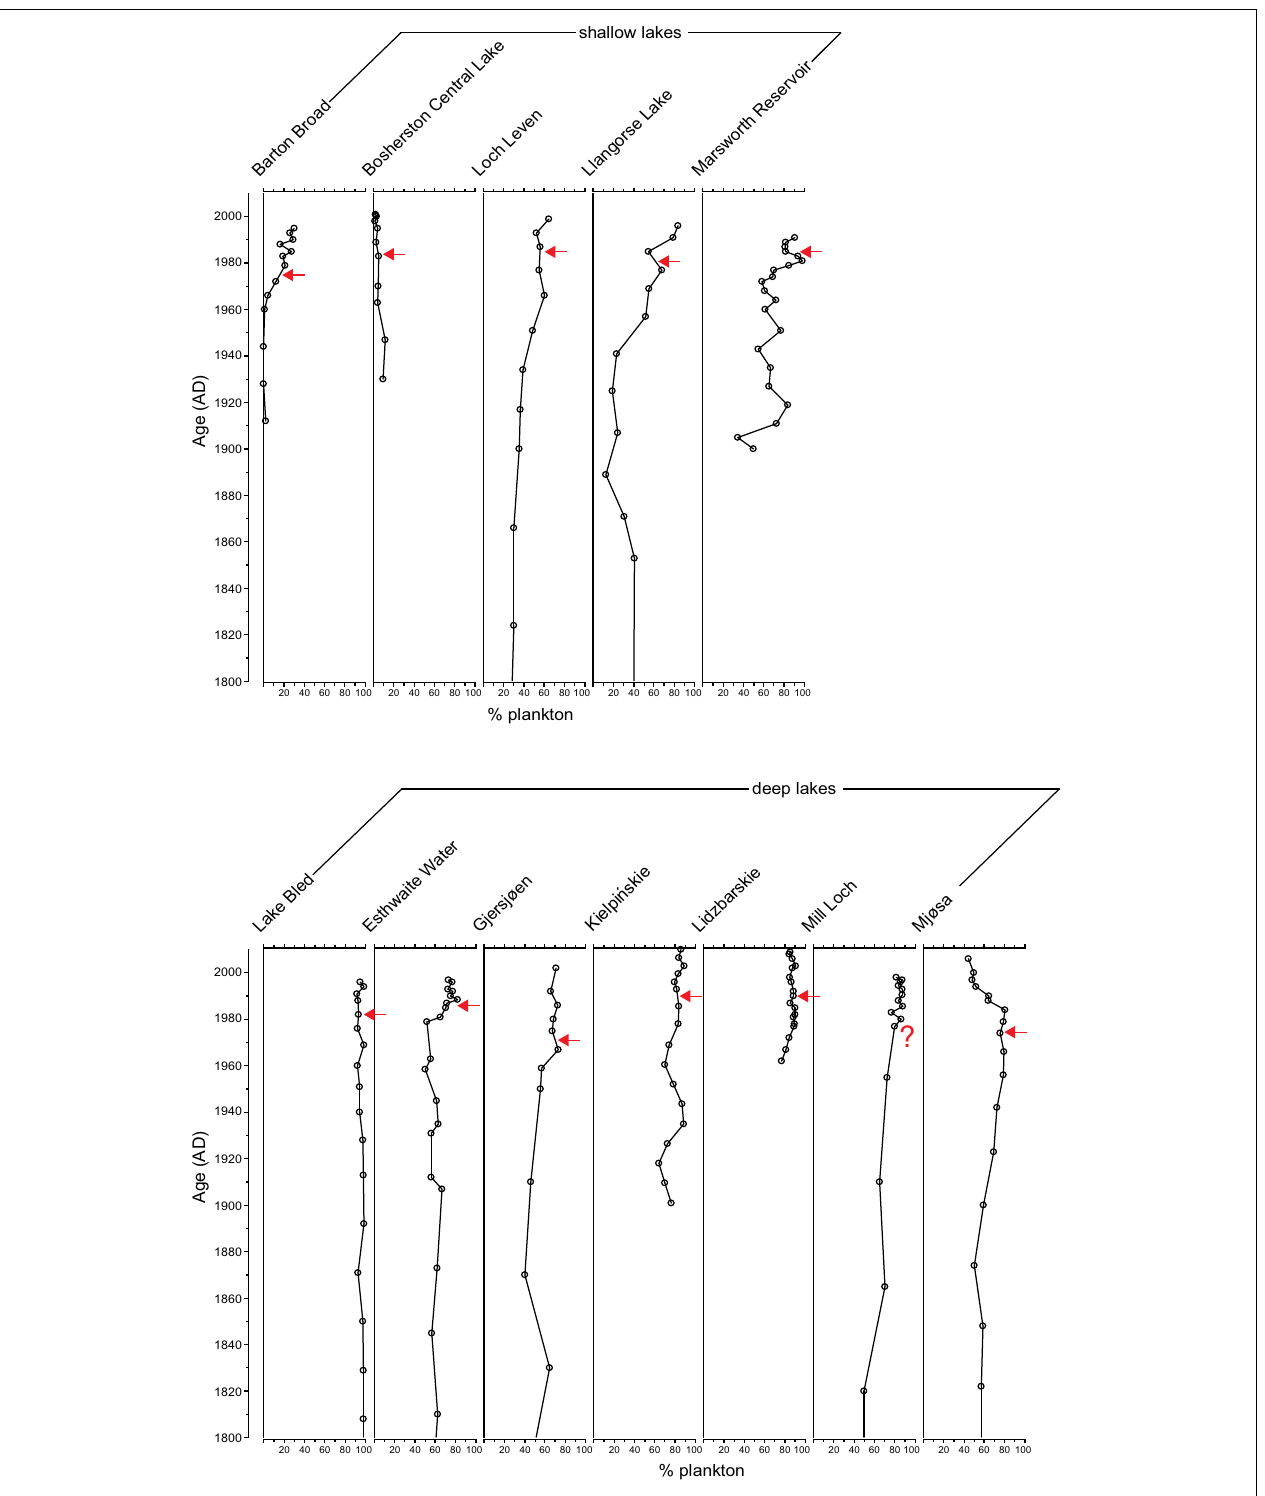
FIGURE 2 | Percentage plankton in the 12 study sites. Timing of first nutrient reduction is shown by the arrow.